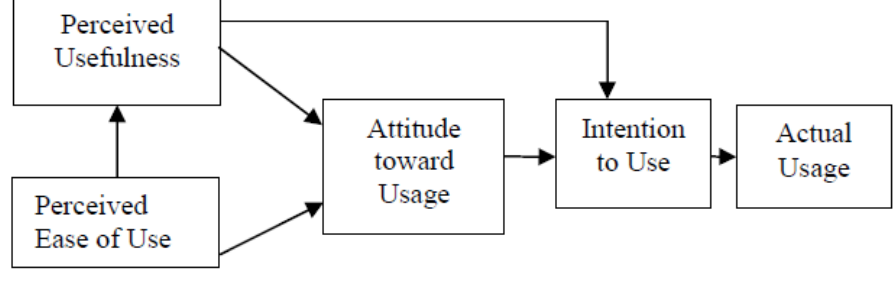
Figure 3 The technology acceptance model (Davis, 1989)